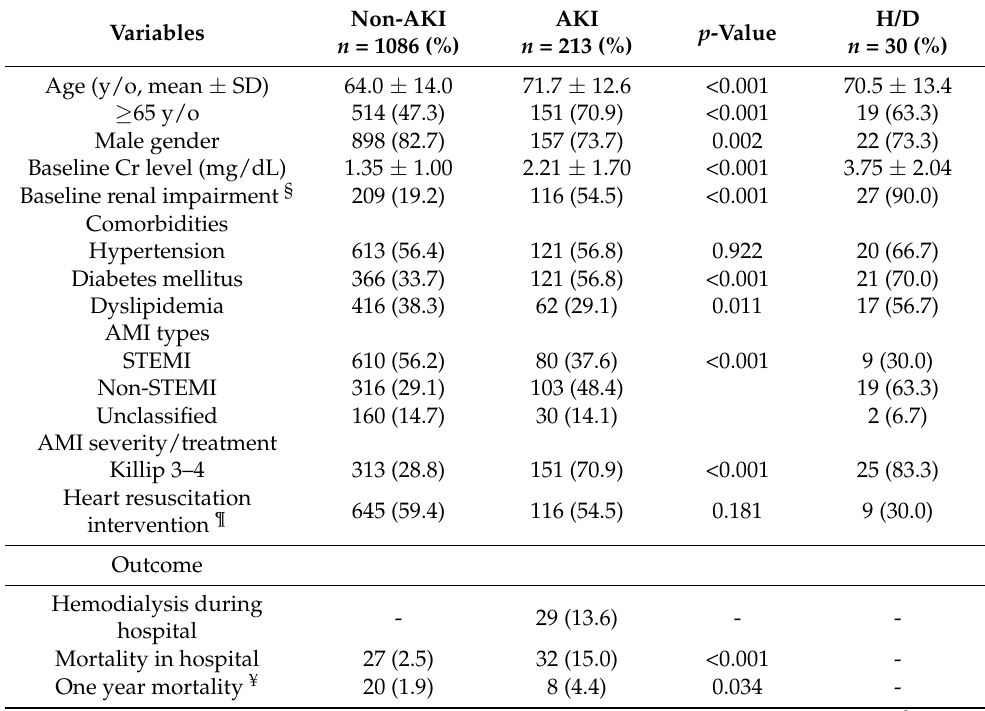
Table 1. Demographics and clinical characteristics of patients in non-AKI and AKI groups.